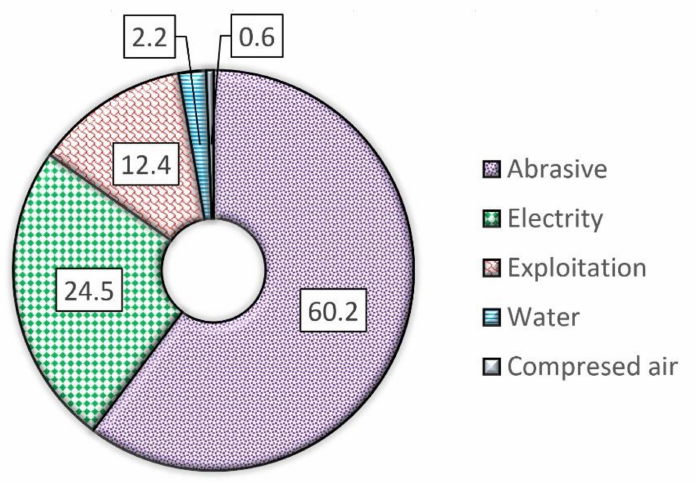
Figure 1. Example percentage cutting costs for the Omax 55100 machining center without amor- tization costs. Media use: garnet abrasive 24 kg/h, electrical energy 30 kWh, water 270 dm 3 /h, compressed air 300 dm 3 /h [12].